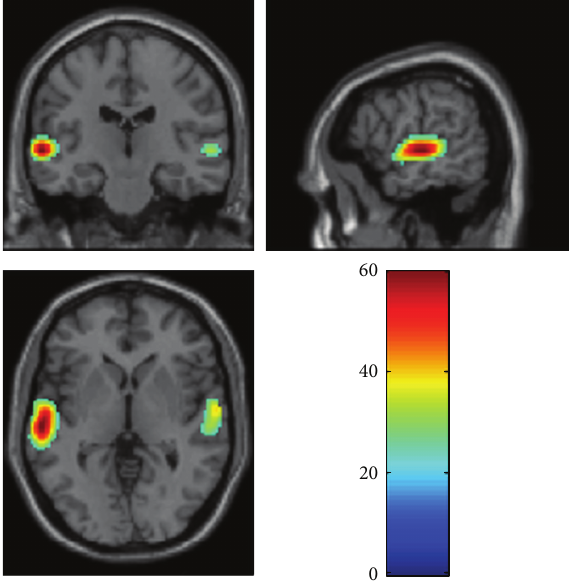
Figure 1: Activation map for main effect of contrast across sub- groups in the whole brain analysis showing greater activity in superior temporal gyri (BA 21/22) during speech